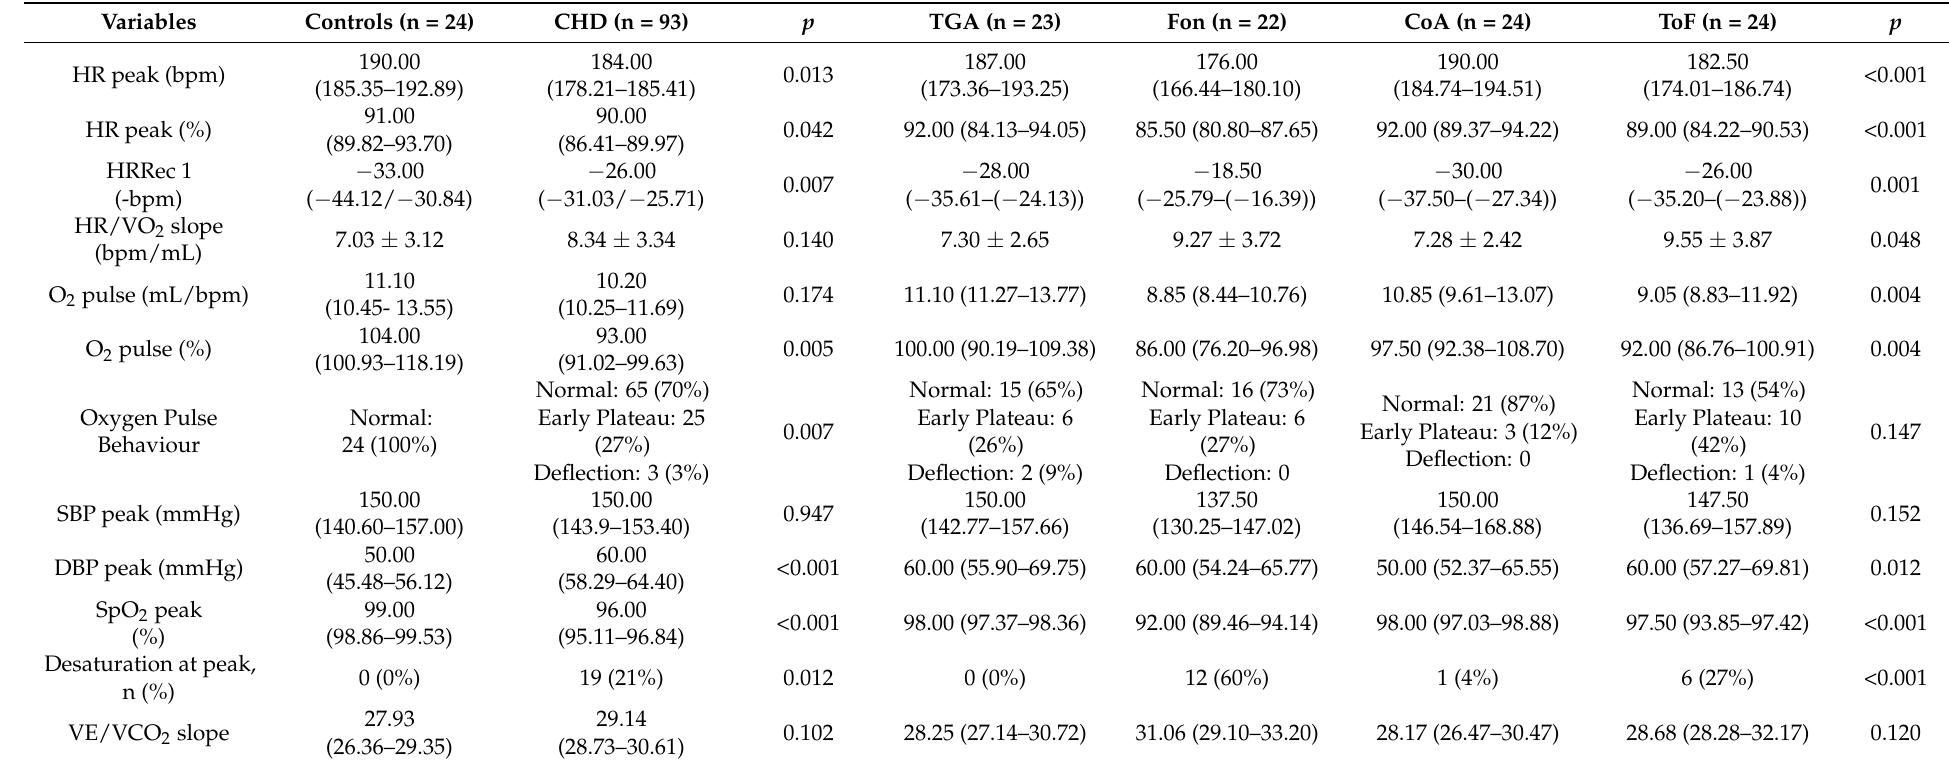
Table 2. Cardiopulmonary test parameters of the healthy controls as well as of the patients with congenital heart disease (CHD). Normally distributed variables are expressed with mean ± standard deviation, non-normally distributed variables are expressed with median and confidence intervals; qualitative variables are expressed with percentages of the total. Intergroup comparison was made between the four CHD subgroups and controls. HR = heart rate; HRRec 1 = heart rate recovery after one minute; VO 2 = oxygen uptake; SBP = systolic blood pressure; DBP = diastolic blood pressure; SpO 2 = peripheral oxygen saturation; VE/VCO 2 slope = minute ventilation/carbon dioxide production slope; VT = Ventilatory Threshold; RCP = Respiratory Compensation Point; OUES = Oxygen Uptake Efficiency Slope; METs = metabolic equivalents of task; LVEF = left ventricular ejection fraction; TAPSE = tricuspid annular plane systolic excursion; FAC = fractional